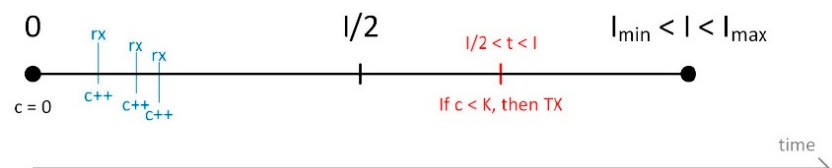
Figure 12. Trickle-based broadcast mechanism and parameters.